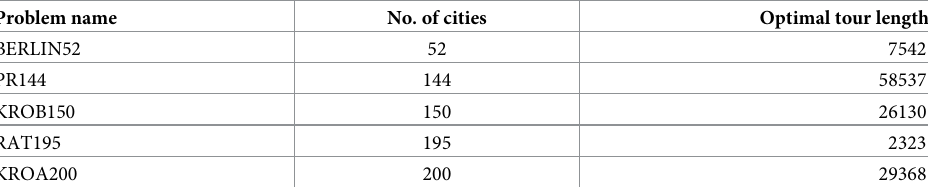
Table 4. The benchmark problems.